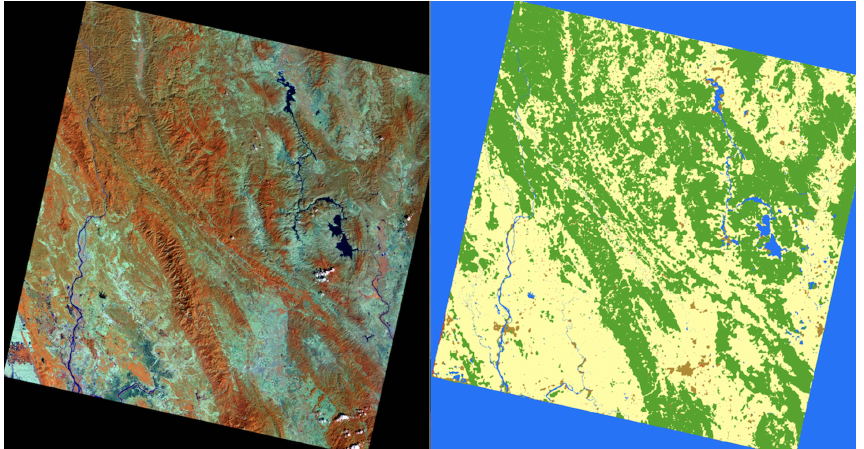
Figure 9. The entire scene’s prediction by “E-PRM-VS-TF” displays the forest and agriculture distinctions in the northern region of Nan Province.